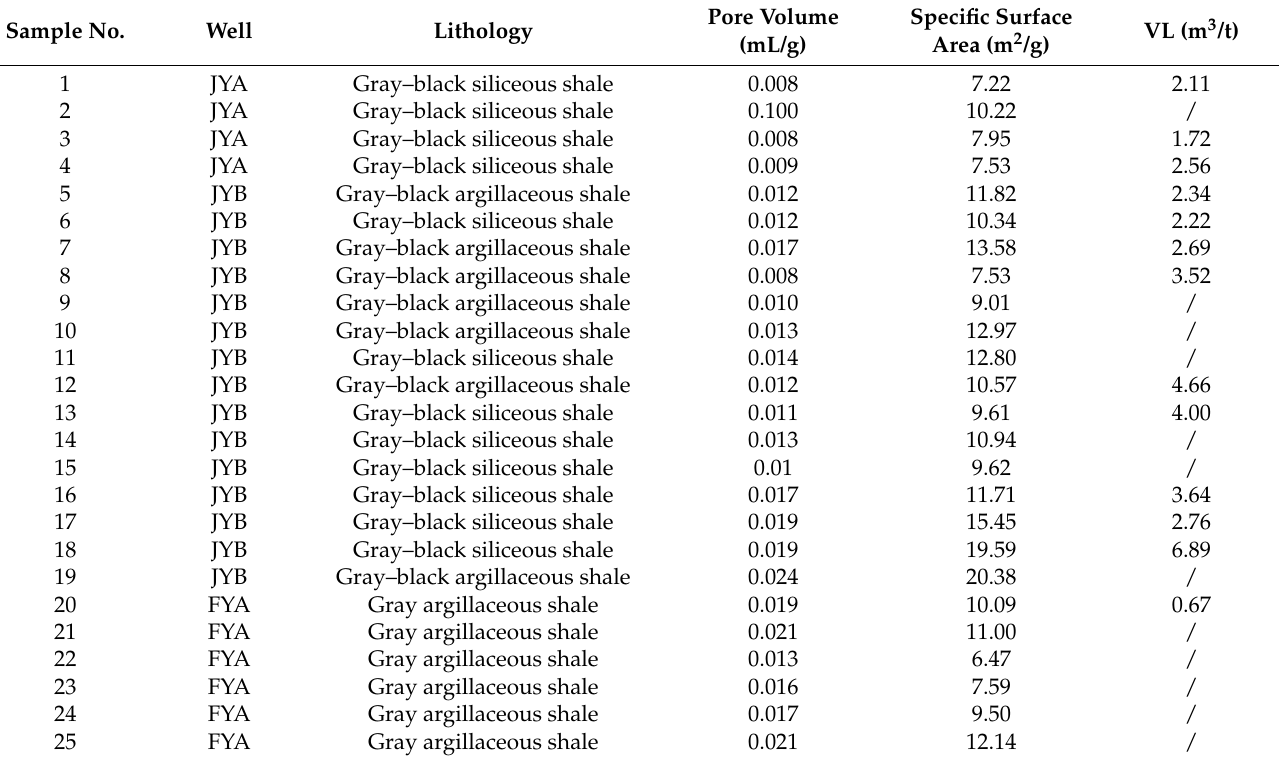
Table 1. Parameters of pore structures of the Silurian Longmaxi marine-shale samples (a) and the Lower Jurassic Dongyuemiao lacustrine-shale samples from the Sichuan Basin. Sample No.